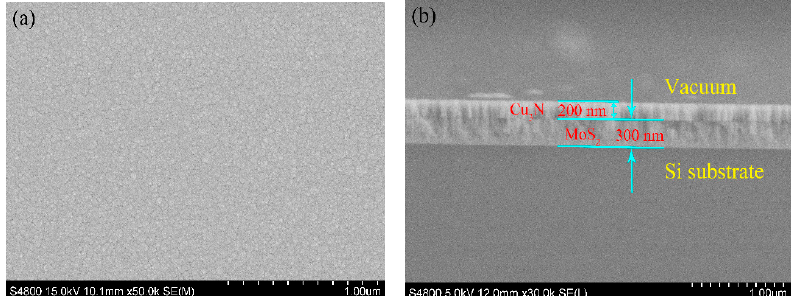
Figure 2. SEM image of Cu 3 N / MoS 2 heterojunction deposited on silicon wafer: ( a ) surface of the MoS 2 layer and ( b ) cross-section of the heterojunction.